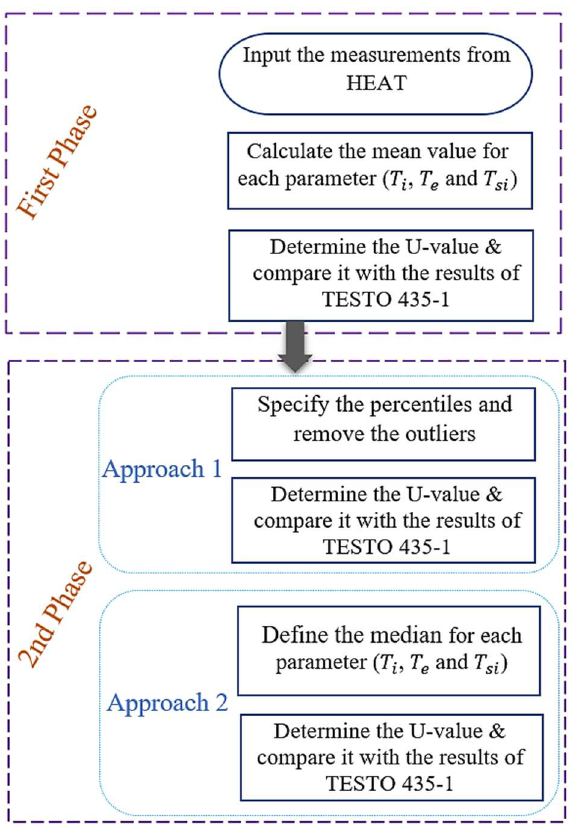
Figure 7. Algorithm to infer the U-value from the measurements of HEAT and the defined ap- proaches to increase the precision of monitoring. to increase the precision of